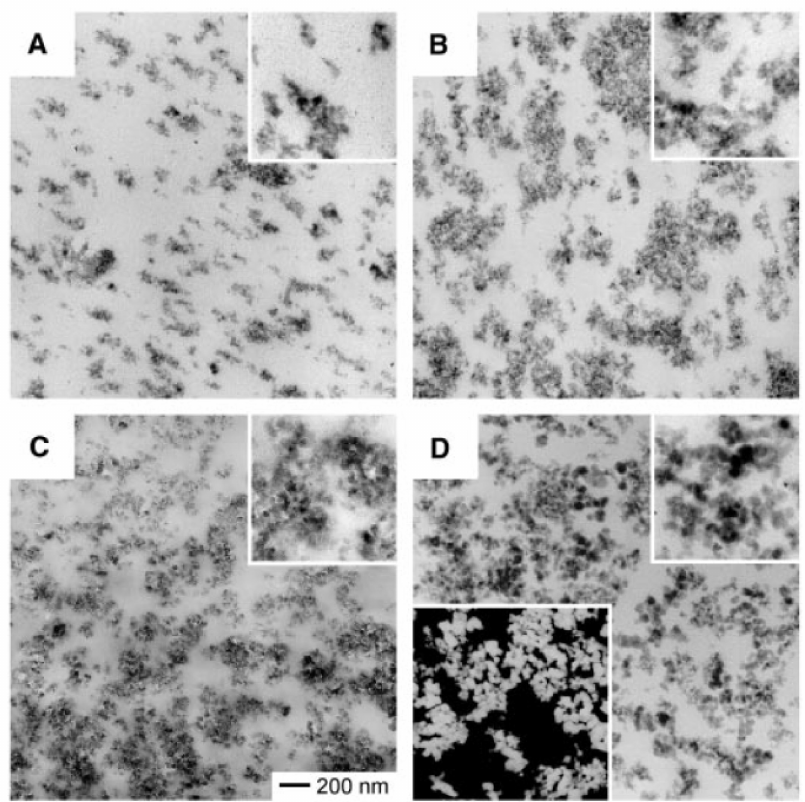
Figure 17. Energy-filtered TEM images of poly(4-methyl-2-pentyne) containing different concentra- tions (in wt. %/vol. %) of a hydrophobic fumed silica (TS-530): ( A ) 15/6, ( B ) 30/13, and ( C ) 40/19. ( D ) shows poly(4-methyl-2-pentyne) containing a hydrophilic fumed silica (L-90) at the same loading level as in ( C ) (used with copyright permission)